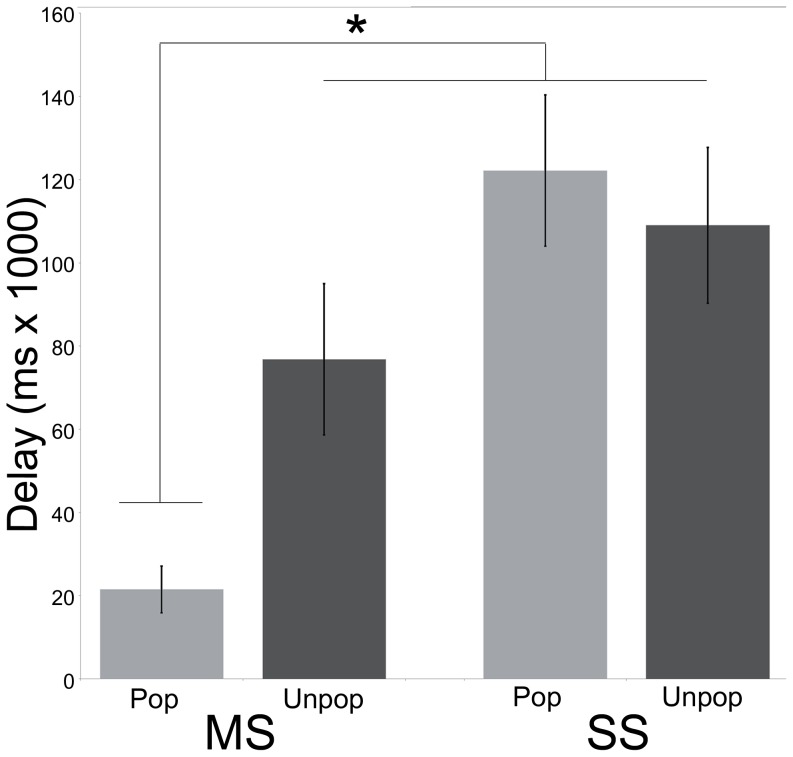
Popular song playback induces selective behavioral response.MS birds display significantly shorter delay times when they hear Popular compared to Unpopular song playbacks. MS delay times during Unpopular song playbacks are no different than SS birds when they hear either Popular or Unpopular song playbacks. Error bars indicate s.e.m.